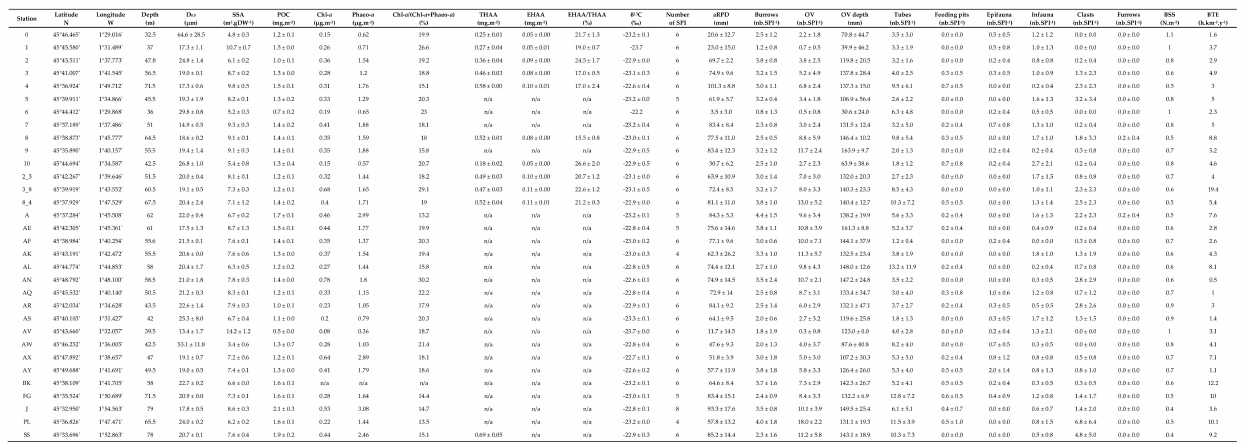
Table A1. Location (WGS84, degrees, and decimal minutes) and depth of the 32 sampled stations, with associated mean values ( ± standard deviation) of surface sediment and SPI characteristics, and Bottom Trawling Effort within cells containing stations. Station positionings are shown in Figure 1. D0.5: median grain size, SSA: Sediment Surface Area, POC: Particulate Organic Carbon, Chl-a: Chlorophyll-a, Phaeo-a: Phaeophytin-a, THAA: Total Hydrolyzable Amino Acids, EHAA: Enzymatically Hydrolyzable Amino Acids, aRPD: apparent Redox Potential Discontinuity thickness, Burrows: number of burrows, OV: number of oxic voids, OV depth: maximal depth of oxic voids, Tubes: number of tubes, Feeding pits: number of feeding pits, Epifauna: number of epifauna, Infauna: number of infauna, Clasts: number of clasts, Furrows: